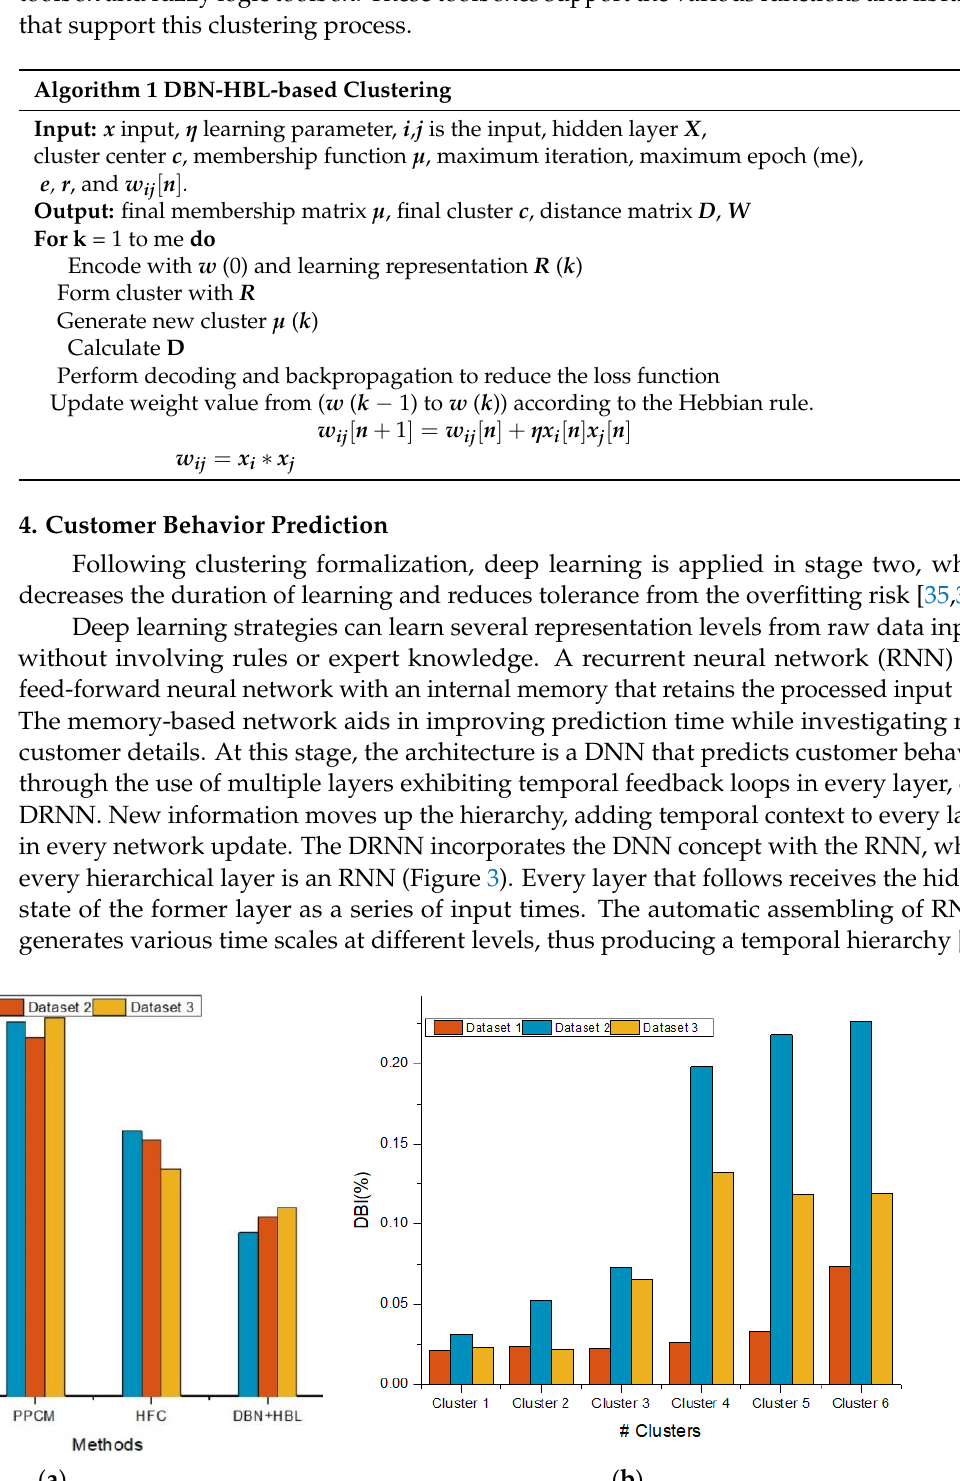
Figure 3. DBI analysis: ( a ) methods, ( b ) clusters.